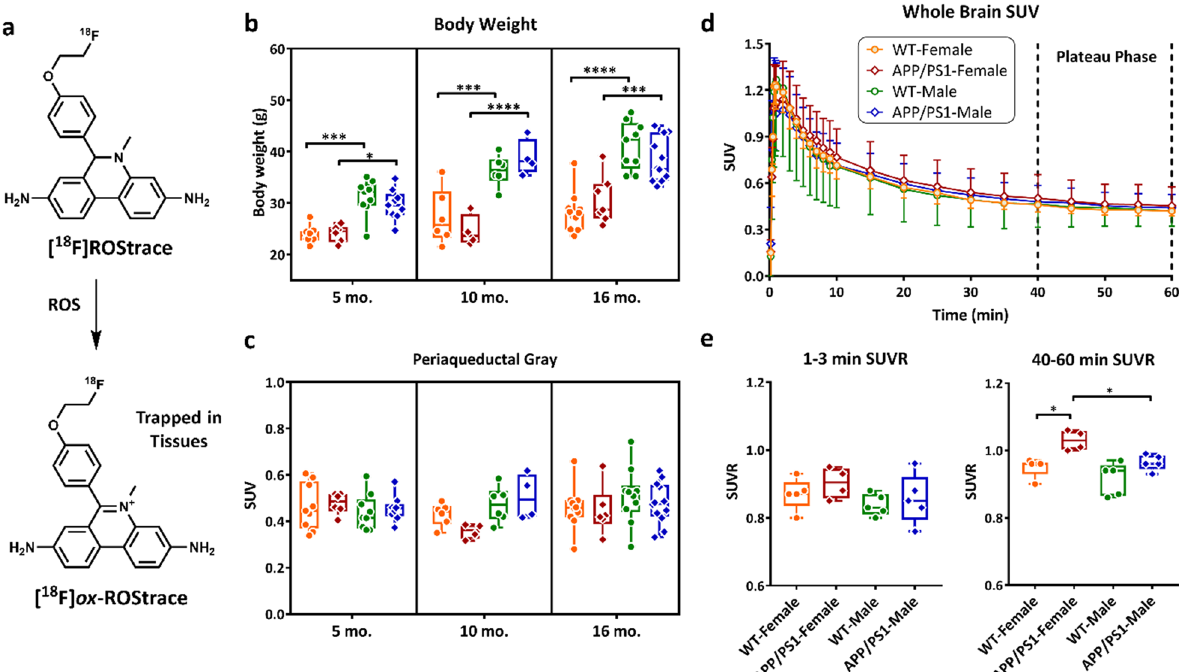
Fig. 1 Validation of the plateau phase and pseudo‑reference region for ox[ 18 F]ROStrace PET analysis. a The chemical structures of [ 18 F]ROStrace and [ 18 F] ox ‑ROStrace. Comparison of b body weight (g) and c periaqueductal gray (PAG) SUV from 40–60 min. 5 mo. old: APP/PS1 group: n 6 for = female, and n 9 for male; WT group: n 9 per gender,10 mo. old: APP/PS1 group: n 4 per gender; WT group: n 6 per gender, and 16 mo. old: = = = = APP/PS1 group: n 6 for female, and n 12 for male; WT group: n 10 per gender. The statistical significance of p value calculated by two‑way = = = ANOVA: **** p < 0.0001, *** p < 0.001, * p < 0.05. Micro‑PET data analysis validates that oxidative stress, not blood flow, contributes the [ 18 F]ROStrace signals in the animal brain. Time–activity curves in SUV of whole brain d in WT female ( n 5), WT male ( n 5), APP/PS1 female ( n 4), and APP/ = = = PS1 male ( n 5) mice at 16 mo. of age. Data are shown as mean standard deviation. Comparison of the average [ 18 F]ROStrace SUVR from 9 VOIs = ± at 16‑mo.‑old animals in e perfusion phase (1–3 min) and plateau phase (40–60 min). (WT groups: n 5 per gender, and APP/PS1 group: n 4 for = = female, and n 5 for male) The statistical significance of p value calculated by one‑way ANOVA (* p < =